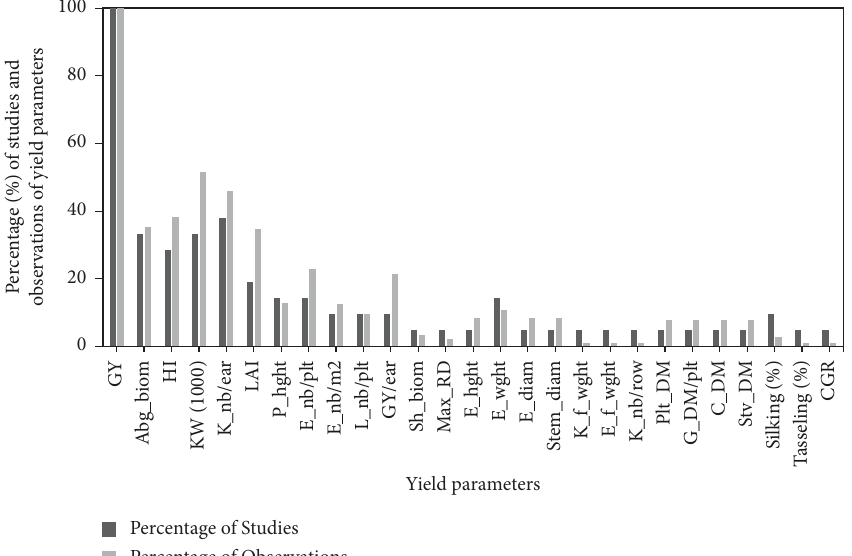
Figure 4: Percentage of studies and observations per yield parameter assessed. GY: grain yield, Abg_biom: above-ground biomass, HI: harvest Index, KW(1000): 1000 kernel weight, K_nb/ear: kernel_number per ear, LAI: leaf Area Index, P_hght: plant height, E_nb/plt: ear number per plant, E_nb/m 2 ; ear number per m 2 , L_nb/plt: leave number per plant, GY/ear: grain weight per ear, Sh_biom: shoot biomass,